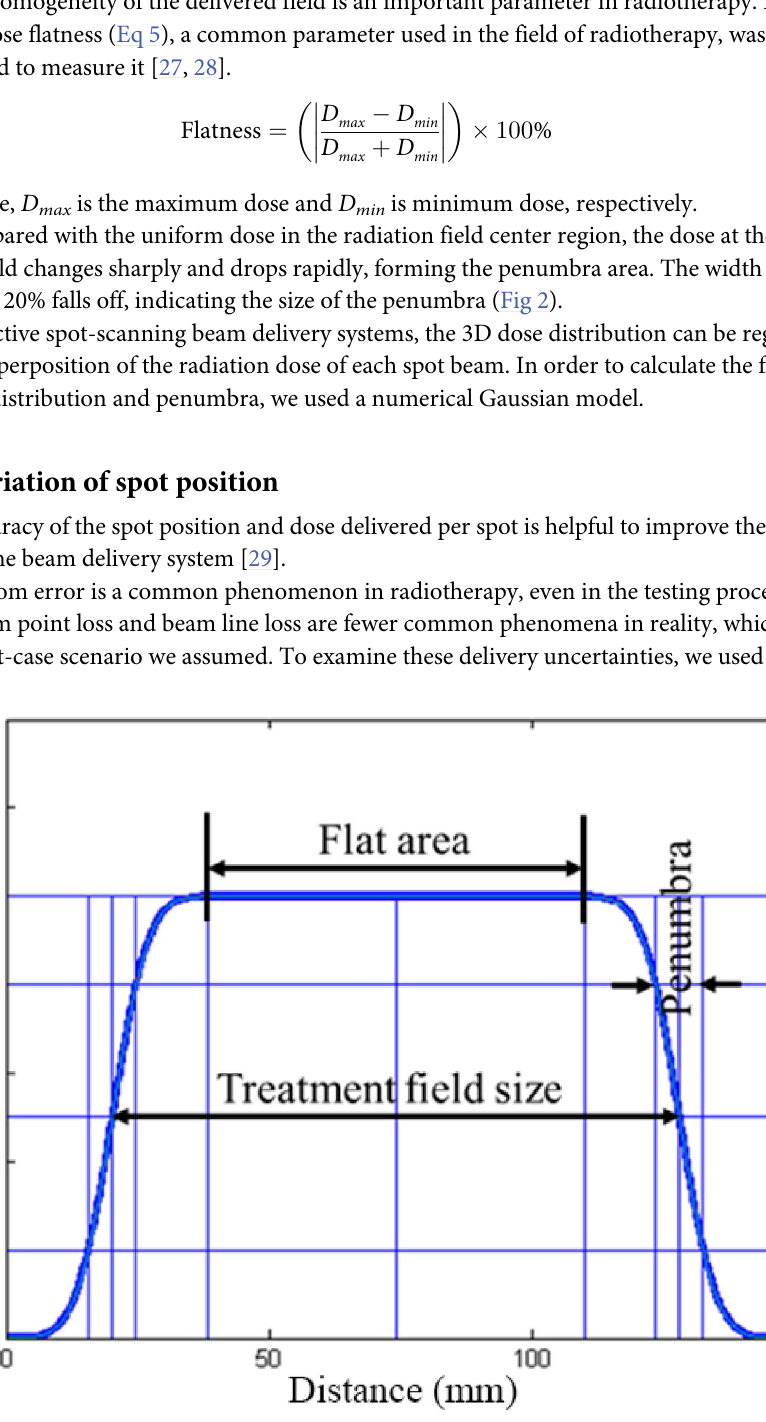
Fig 2. Schematic illustrations of concepts underlying the computational